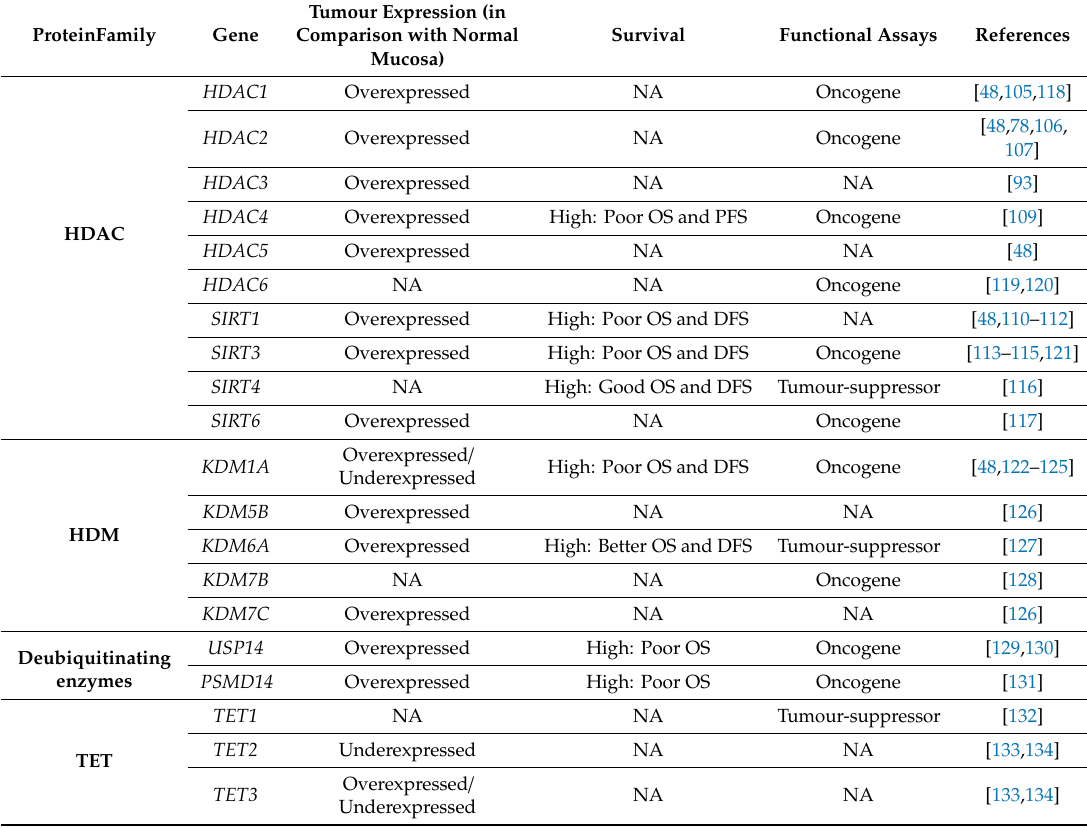
Table 2. Summary of the most relevant publications concerning the role of DNA / histone erasers involved in oesophageal